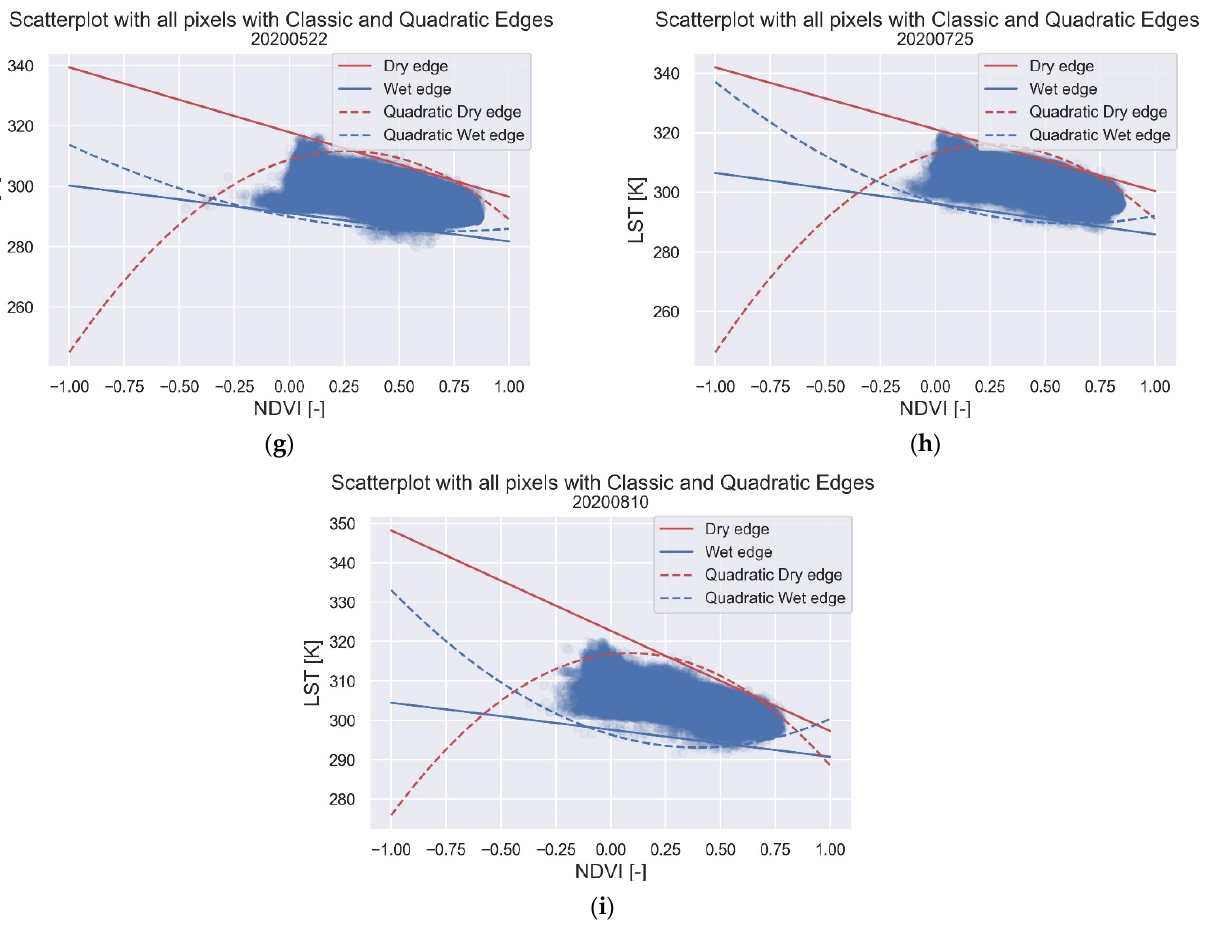
Figure 4. LST ‐ NDVI scatter plots with dry and wet edges with all pixels plotted for all analyzed dates:( a ) 20 June 2013, ( b ) 6 July 2013, ( c ) 22 May 2014, ( d ) 7 June 2014, ( e ) 10 August 2014, ( f )